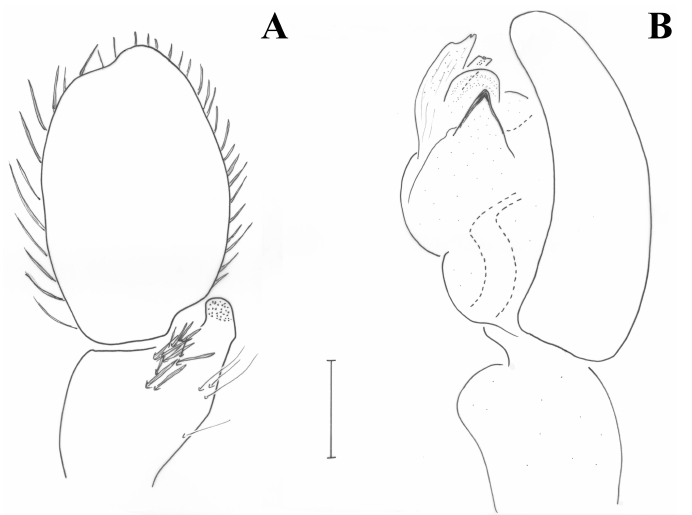
Figure 3. Civizelotes akmon n.sp. (holotype), male pedipalp. ( A ) Dorsal view, ( B ) prolateral